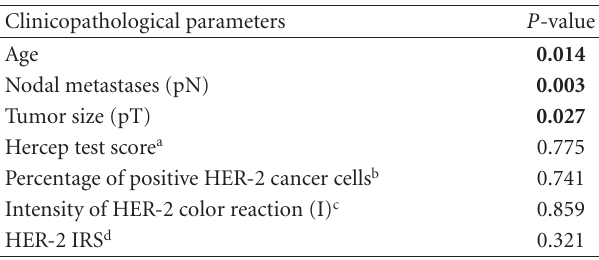
Table 4: Multivariate Cox proportional hazard regression analysis of HER-2 expression and clinicopathological parameters influence on patients overall